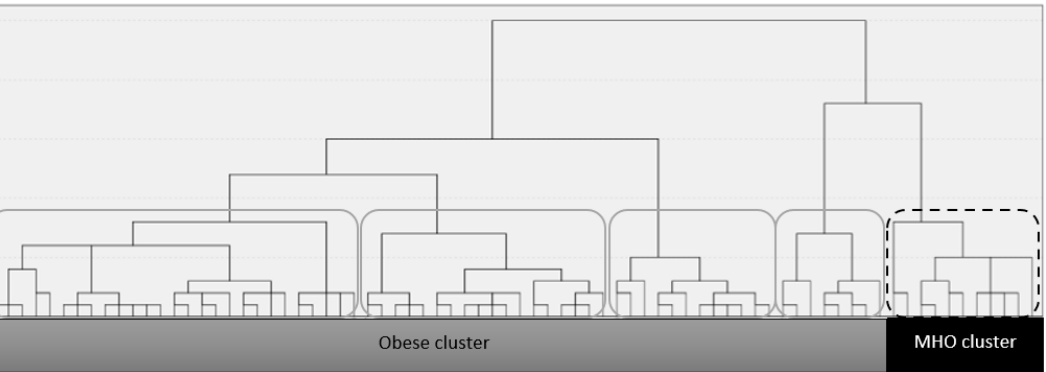
Figure 1. Hierarchical clustering classification tree.